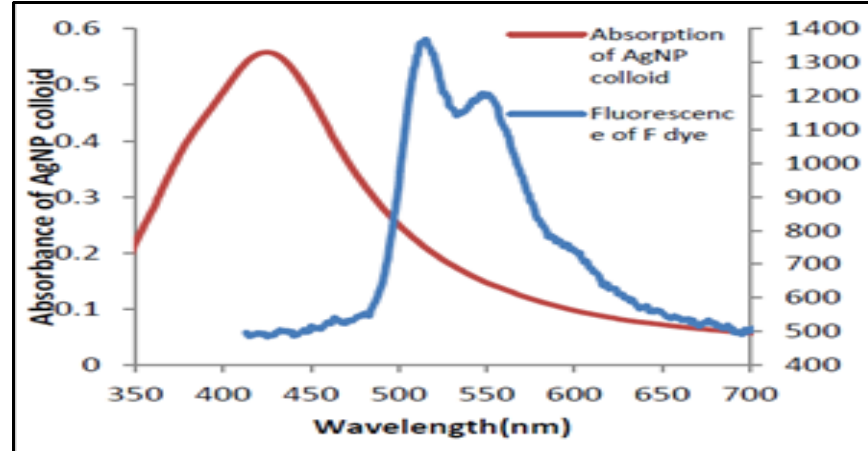
Figure 7: Overlap spectra between the surface plasmon absorption of Ag NPs (5min.) and the Fluorescence of fluoreseina dye.